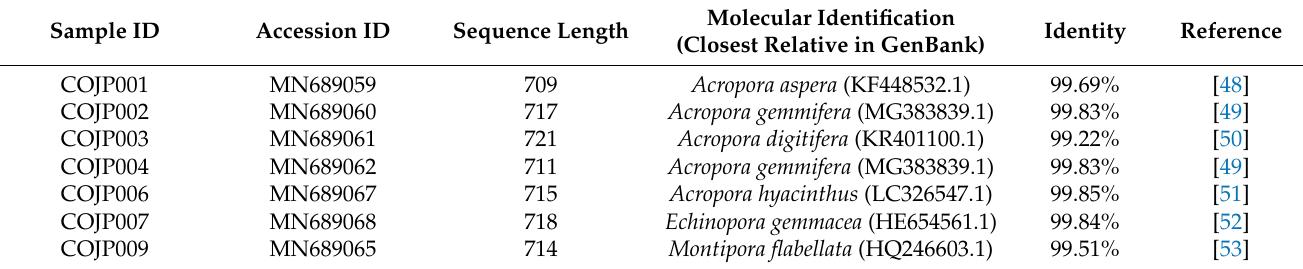
Table 5. List of samples sequenced in this study and the most closely related barcodes found in GenBank, together with their accession numbers, and the publisher of the